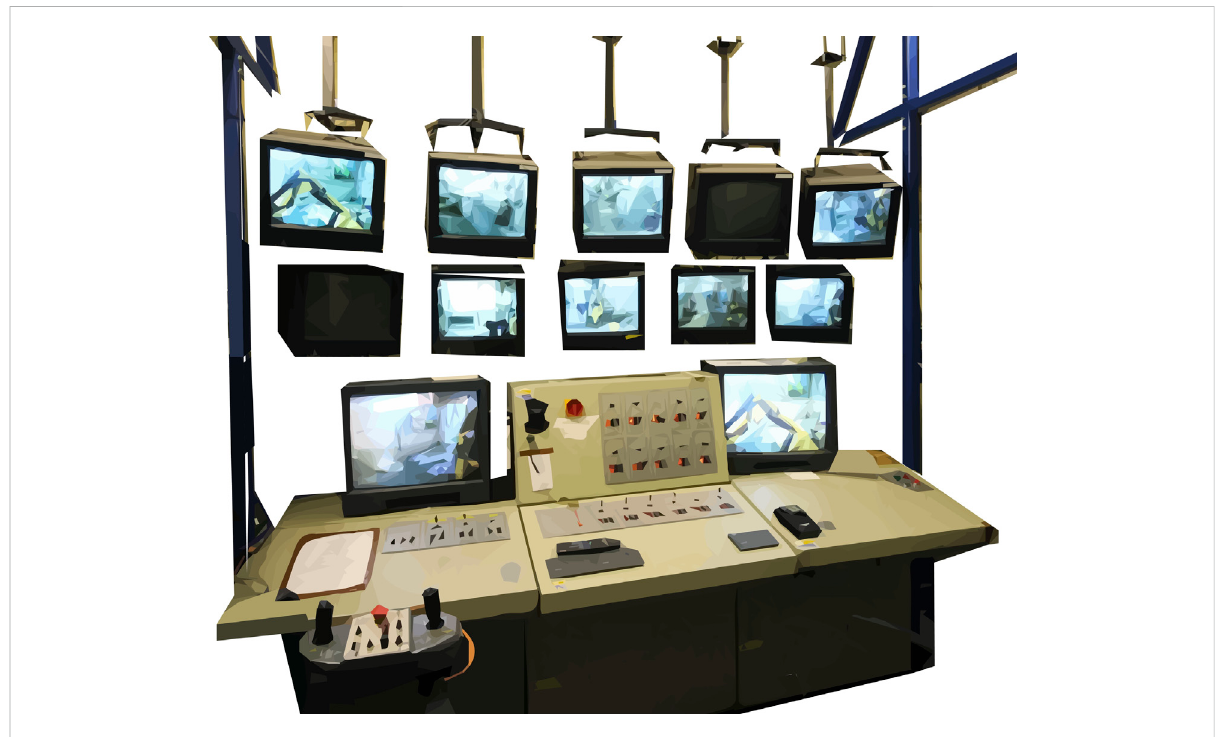
FIGURE 1 A robot teleoperation workstation at Sella fi eld. Artistic adaptation from (Temperton,